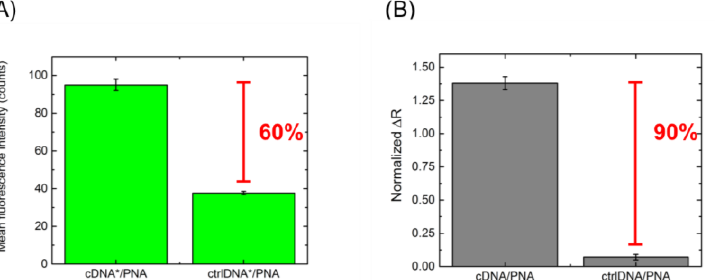
Figure 8. ( A ) Mean fluorescence intensity values of ZnONW-based devices after interaction with 100 µM cDNA* and 100 µM ctrlDNA* . ( B ) Normalized ∆ R calculated from I–V curves of ZnONW-based devices after interaction with 100 µM cDNA and 100 µM ctrlDNA .